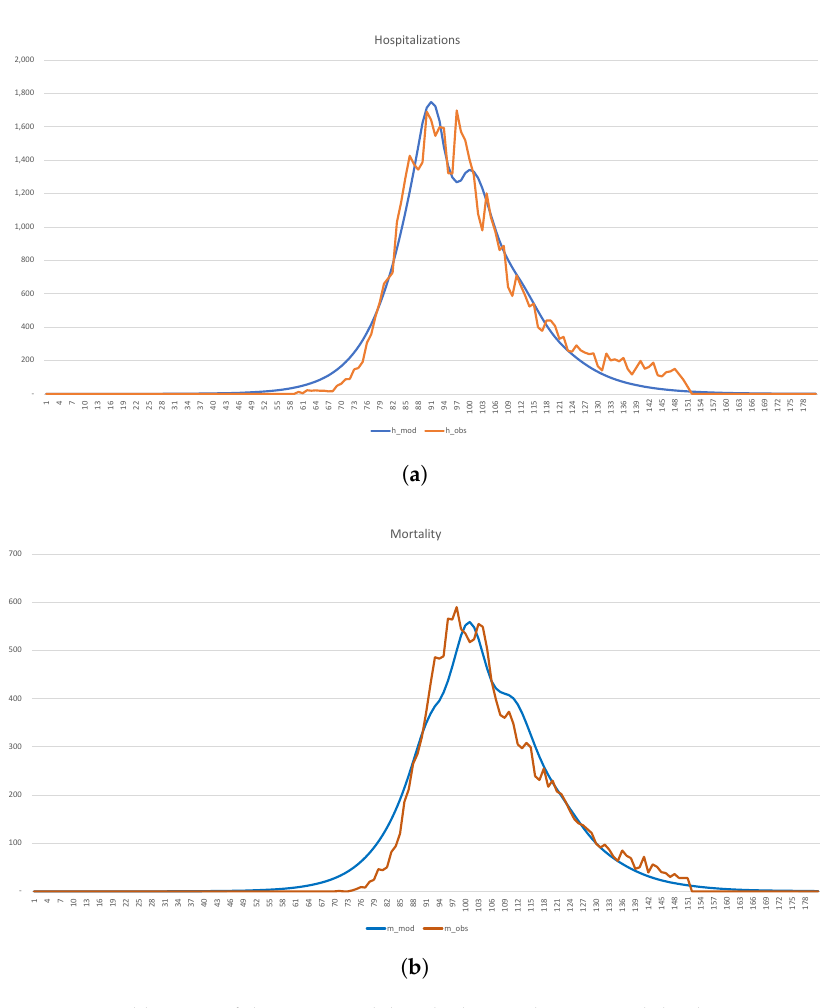
Figure 18. Calibration of the SEIR model to the hospitalization and death statistics in NYC. ( a ) Hospi- talizations ( b )